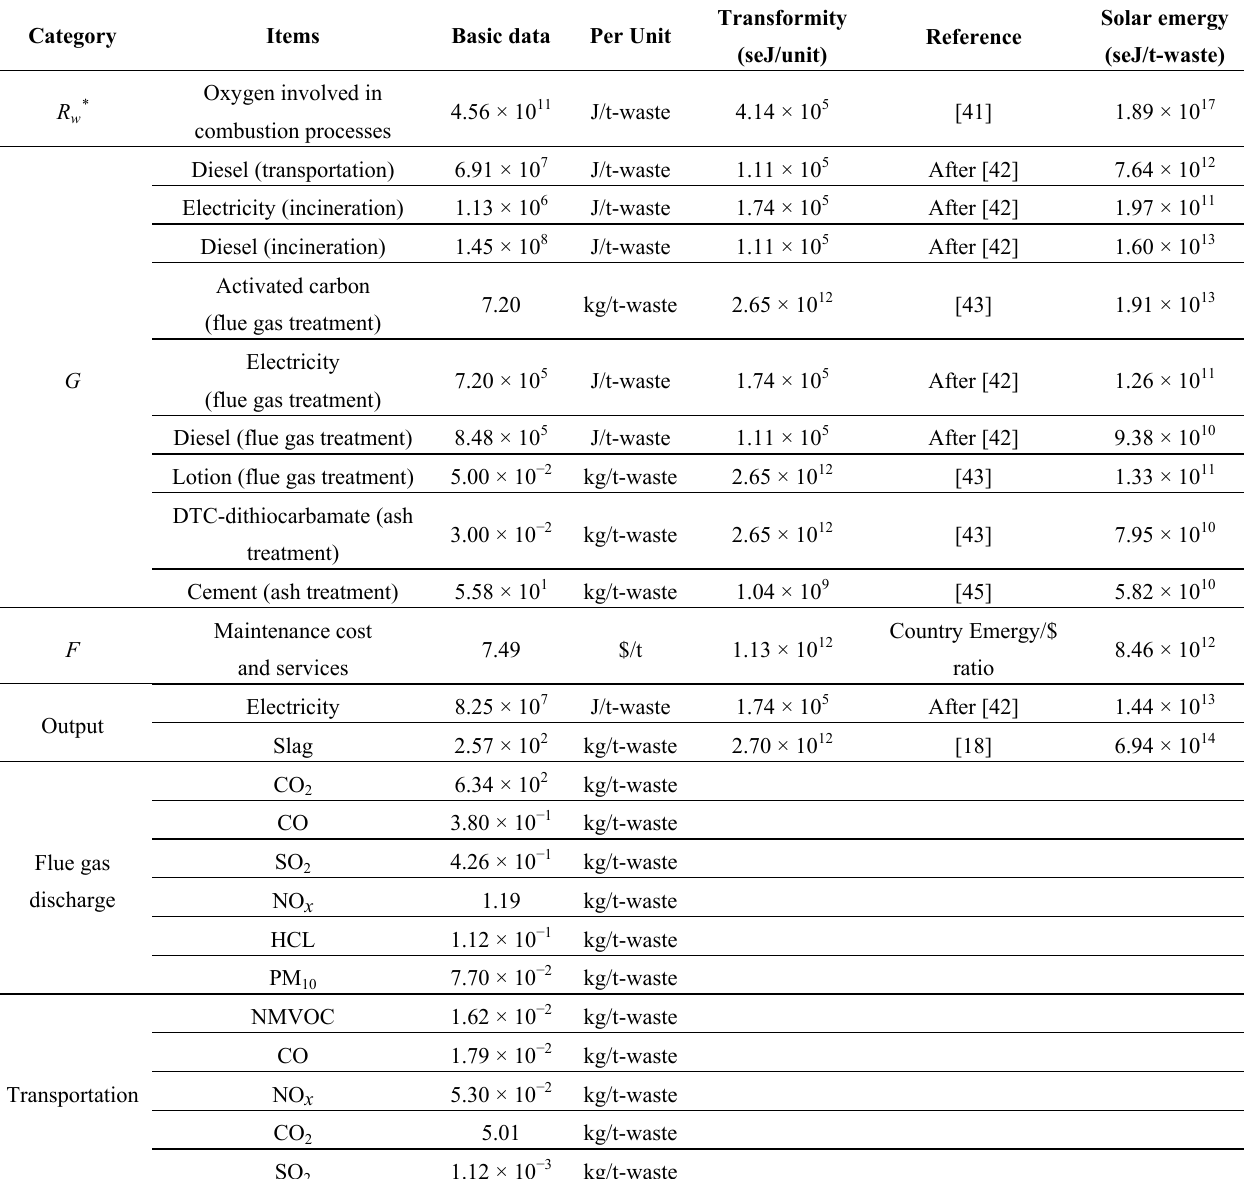
Table 4. The emergy analysis table of grate type incineration.